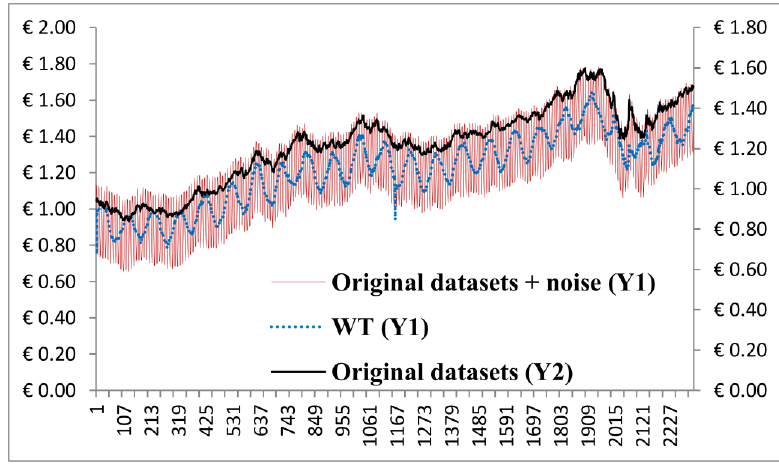
Figure 8 . Plots of the original datasets, original datasets + noise, and the Wavelet Transform (WT) algorithm.